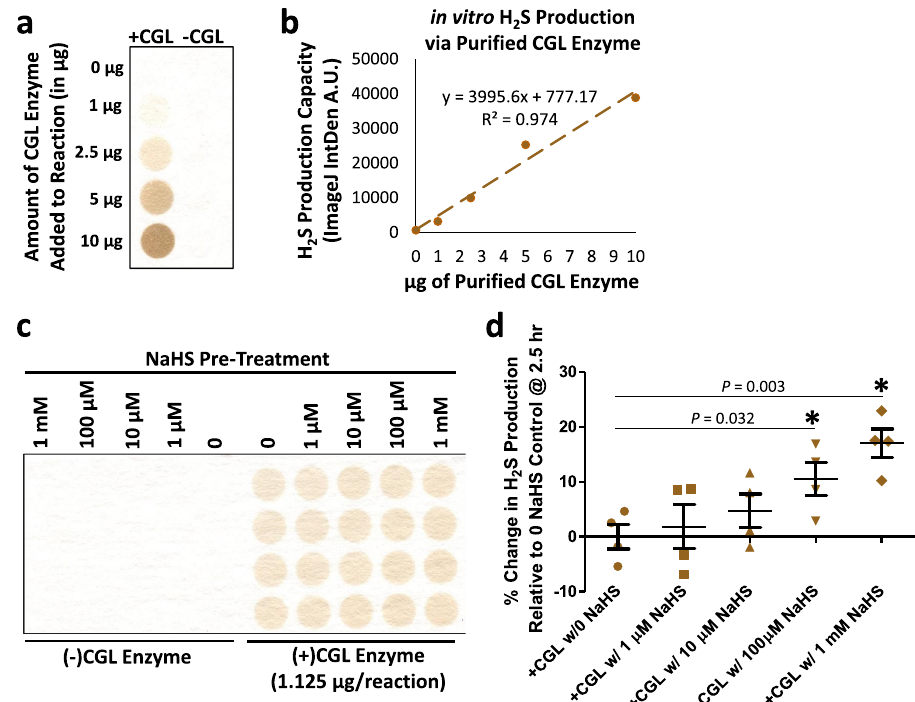
Fig. 6 NaHS pretreatment augments H 2 S production capacity of CGL. a , b Detection via the lead acetate/lead sul fi de method ( a ) and quanti fi cation via integrated densitometry ( b ) of CGL-derived H 2 S production in reaction mixtures containing L-cysteine and pyridoxal phosphate after 2 h incubation at 37 °C. c , d Pretreatment with NaHS prior to incubation at 37 °C dose dependently increases CGL-derived H 2 S production capacity after correcting for detection of non-enzymatic H 2 S off-gassed in the corresponding ( – )CGL wells ( c ). Plot of the percent change in H 2 S production relative to the ( + )CGL w/0 µ M NaHS control. Error bars are ± SEM. The given individual P values are calculated from two-sided t test without multiple comparison test, while asterisks indicate P < 0.05 calculated from one-way ANOVA with Dunnet ’ s Multiple Comparison Test. n = 4/reaction condition. Source data are provided as a Source Data fi le. See also Supplementary Fig.